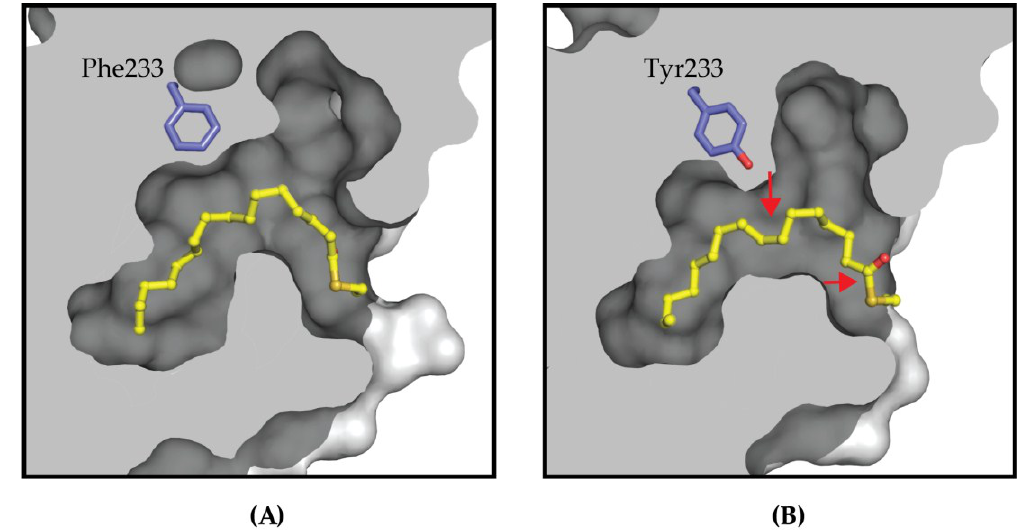
Figure 5. The palmitate group (colored yellow) extends towards the interior of YBD shown as a grey surface representation. The lipid pockets of ( A ) TEAD2 and ( B ) TEAD3 are identical except for the Phe/Tyr difference, which is shown in blue stick format. For TEAD3, the bulkier Tyr233 requires the lipid chain to reorient relative to the TEAD2 structure. The most noticeable reorientations are marked with red arrows on the TEAD3 lipid pocket to illustrate the alkyl chain moving down and the carbonyl group rotating out towards the solvent.